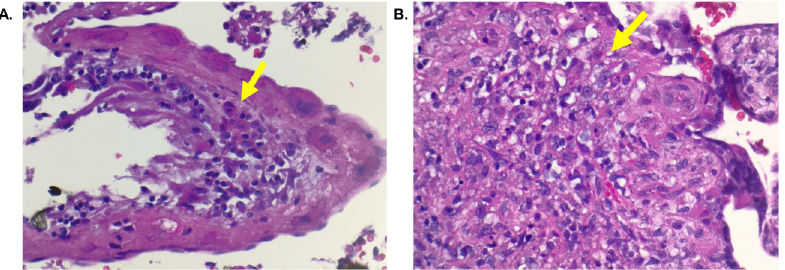
Fig 2. Histology of the placenta from a ZIKV-infected pregnant mother. Placental tissue from subject B1_0004 was stained with hematoxylin and eosin. Lymphocytes and macrophages are present in the chorionic villi ( A -100X, B - 400X). The arrow indicates inflammatory cells within a